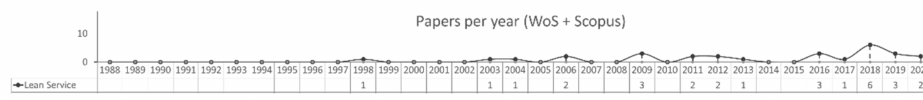
Figure 14. Lean services